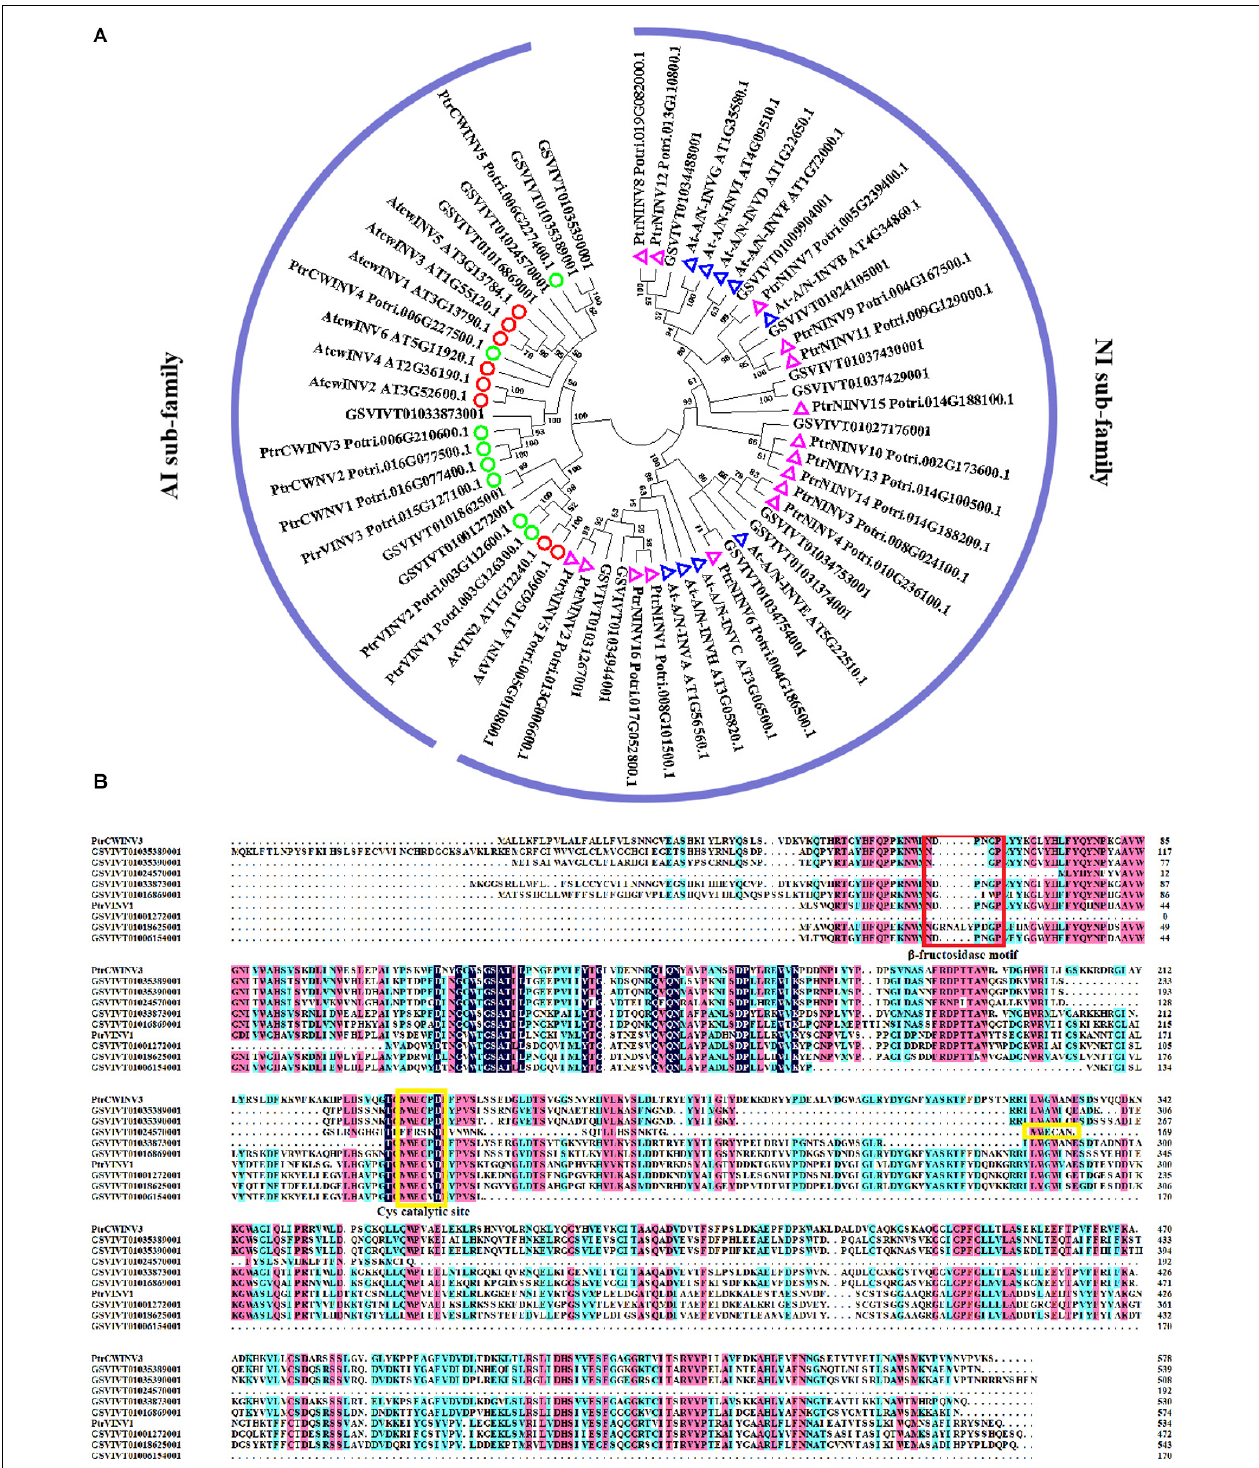
FIGURE 1 | (A) Phylogenetic tree of invertase genes from different plants. Amino acid sequences from Arabidopsis (tair database), populus (Chen et al., 2015) and grapevine were used to construct the unrooted phylogenetic tree by MEGA v. 6.0 (Tamura et al., 2013) with the neighbor-joining (N-J) method, p-distance, pairwise deletion method, and a bootstrap test with 1,000 replicates. The red and green circles indicate vacuolar acidic invertases and cell wall acidic invertases of Arabidposis and populus, respectively. Blue and purple triangles indicate alkaline/neutral invertase of Arabidposis and populus, respectively. (B) Multiple alignment of the acid invertase sub-family in grape with two known populus vacuolar acidic invertase (PtrVINV1) and cell wall acidic invertase (PtrCWINV3) as references. The red box shows β -fructosidase motif (DPNGP), the yellow box shows the cys catalytic site (MWEC-P/V-D).